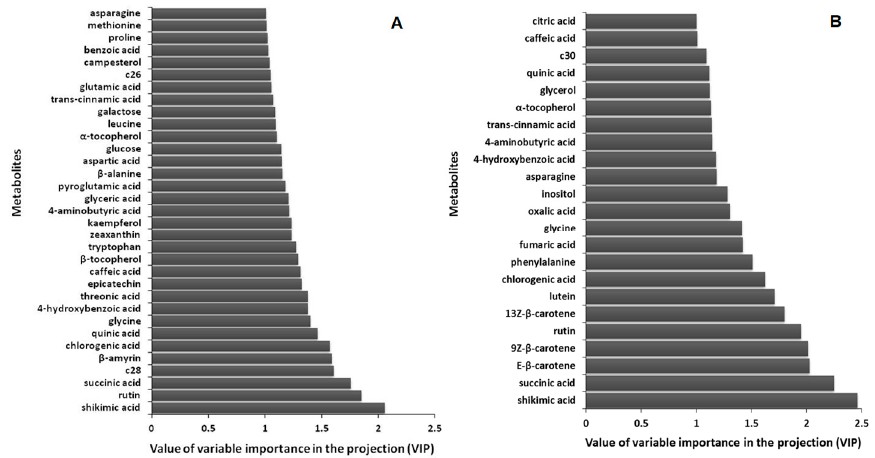
Figure 6. The influence of variables used to create DPPH free radical scavenging ( A ) and the reducing power ( B ) predictor for Mentha spp. C26, hexacosanol; C28, octacosanol; C30, triacontanol.